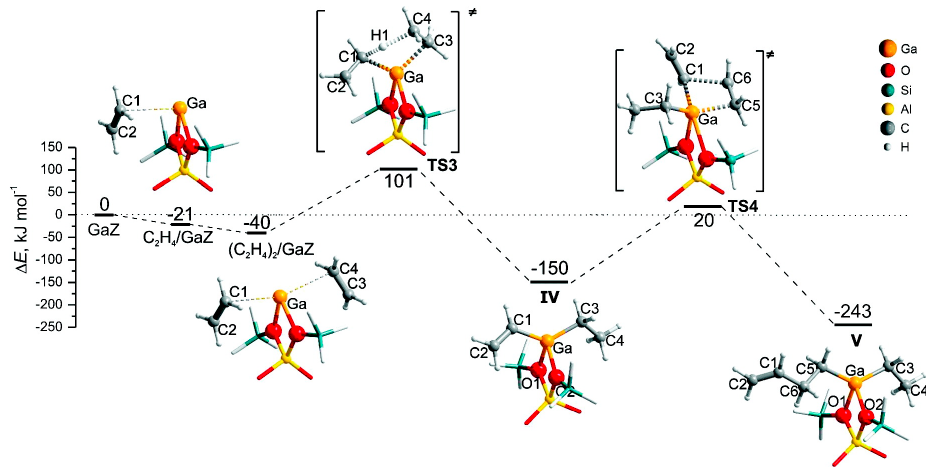
Figure 15. Ethylene dimerization over Ga + Z − . Reprinted with permission from ref [114]. Copyright 2008 American Chemical Society.